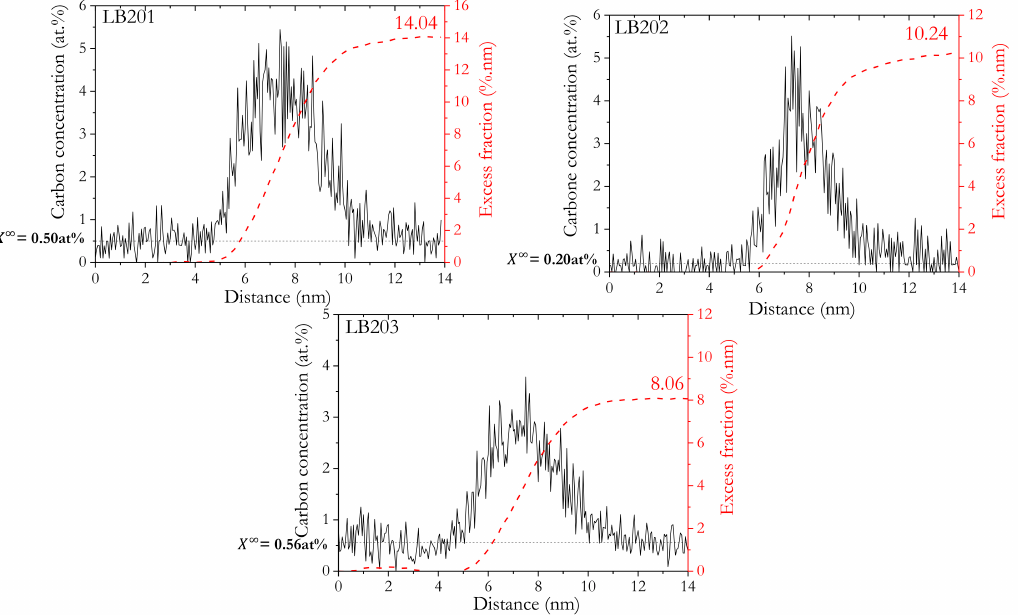
Figure 21. Concentration profiles (black solid line) of the lath boundaries (LBs) presented in Figure 20 along with the integral (dashed red line) representing the excess fraction (QT200 PT / t = 400 ◦ C / 200